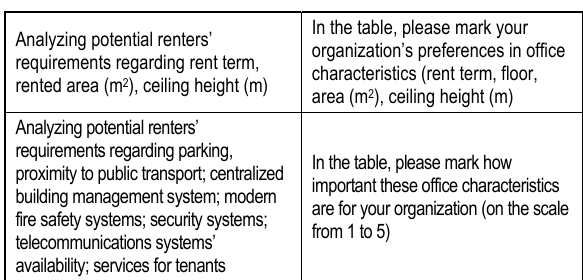
Fig. 1. Shopping center’s services rating